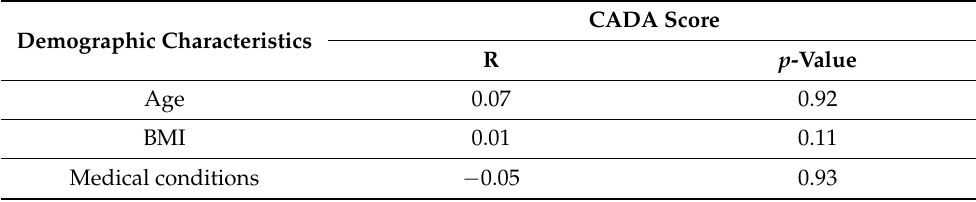
Table 3. Correlation between participant characteristics and CADA